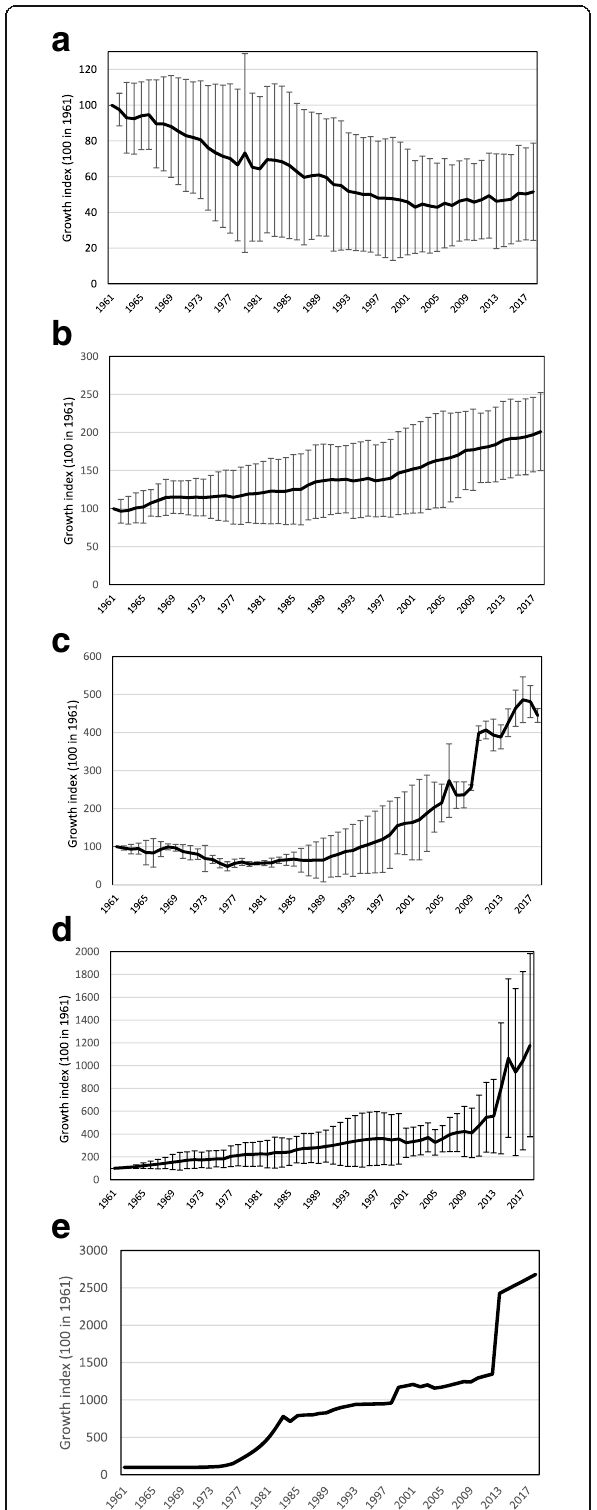
Fig. 1 Changes in camel demography from 1961 to 2018 according to different patterns. a Mean and standard deviation (SD) of camel population among camel countries with decline growth (type 1). b Mean and SD of camel population among camel countries with slight regular increase (type 2). c Mean and SD of camel population in Syria and UAE with decline followed by important growth (type 3). d Mean and SD of camel population with a sharp increase since 2010s after regular growth (type 4). e Change in camel population at Sultanate of